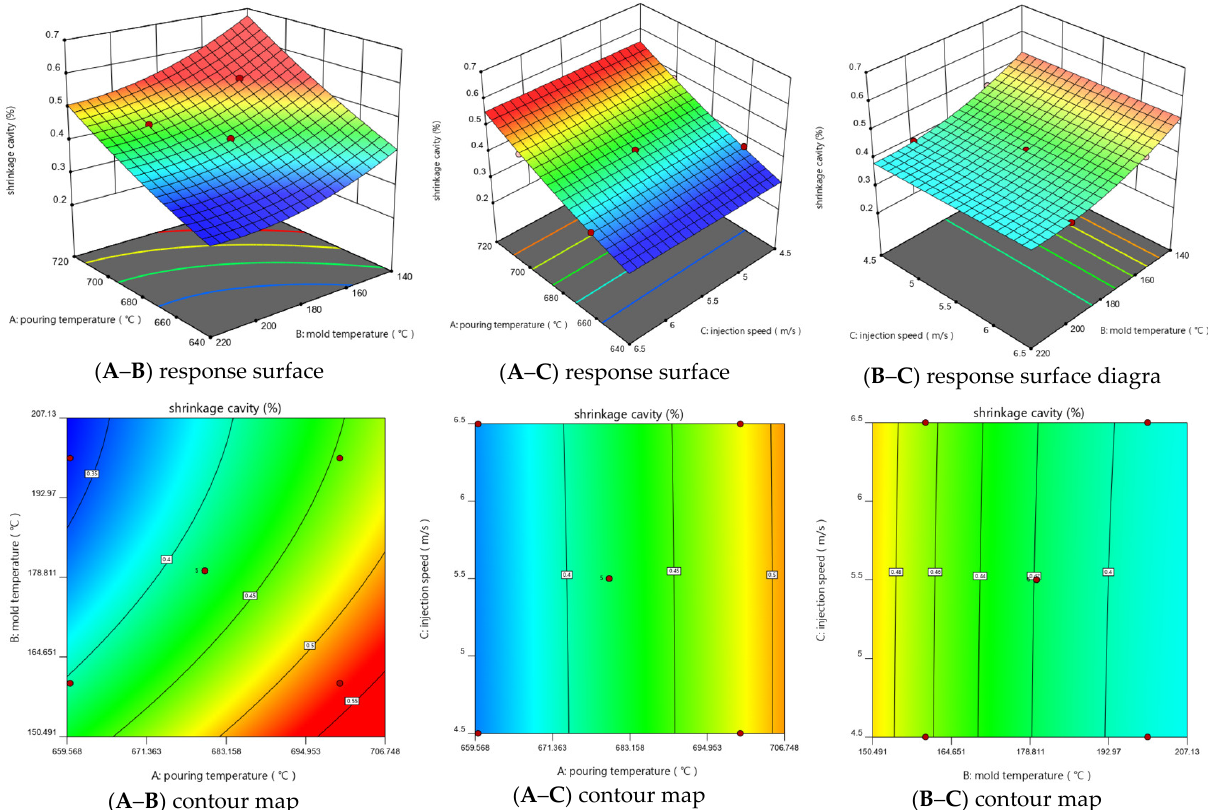
Figure 7. Interactive effect of two factors on shrinkage cavity rate (Y 2 ).